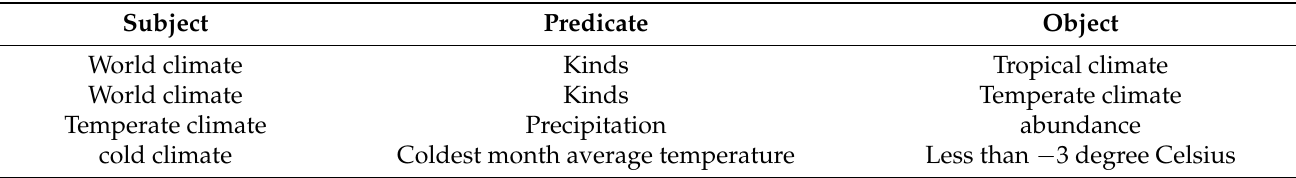
Table 2. (Chapter 1. World Climate Area) triple example that can be configured while conducting classes.